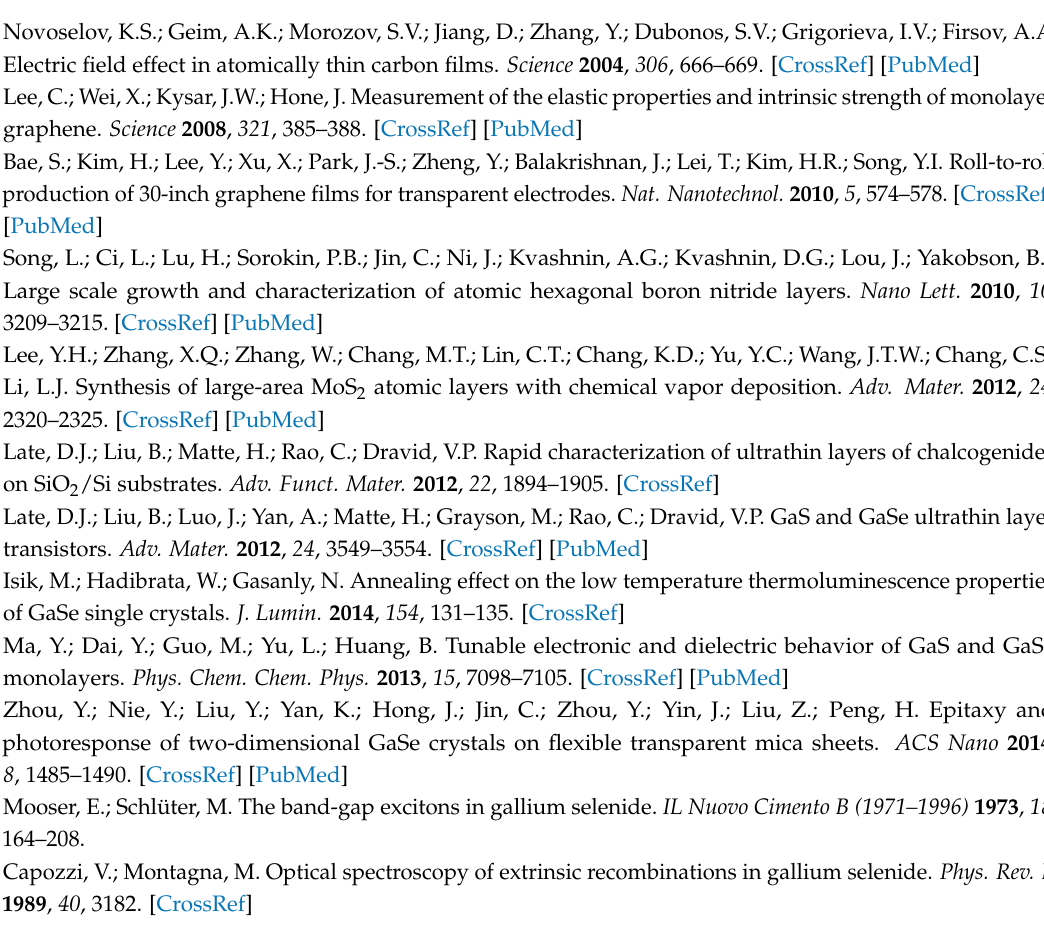
wrinkled GaSe sheet; Figure S3: The line intensity profile of the AFM image; Figure S4: Calculation of strain within GaSe wrinkles; Figure S5: The temperature dependence of the intensity ratio of P I (direct band gap transition) to P II (indirect band gap transition); Figure S6: Temperature-dependent PL measurements at different locations of the wrinkled